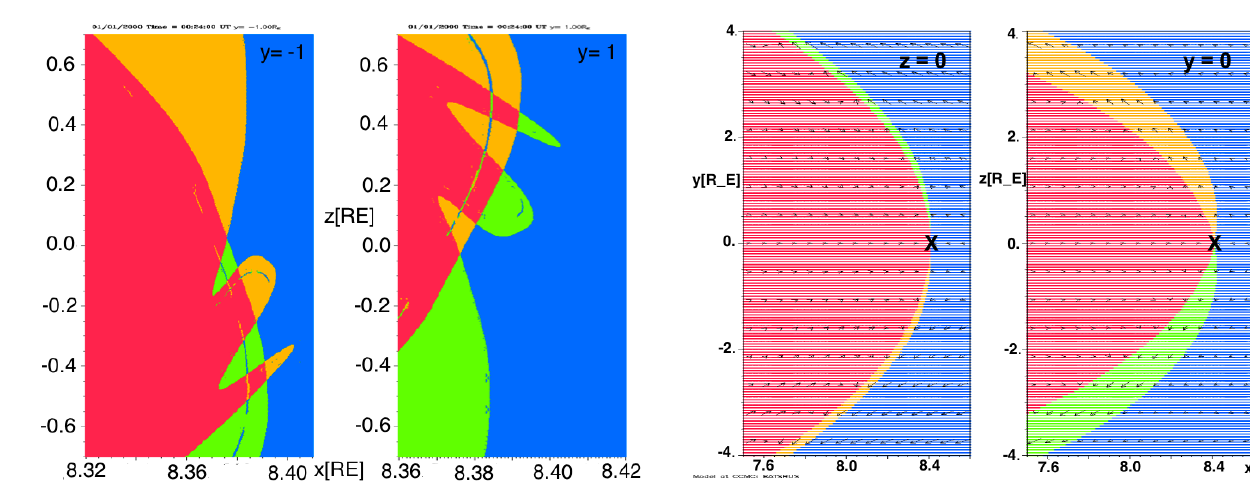
Fig. 15. Magnetic topology at t = 0 for y = − 1 and 1 R E . Colors are related to magnetic topology as red, closed; yellow, connected to north; green, connected to south; and blue, solar wind.